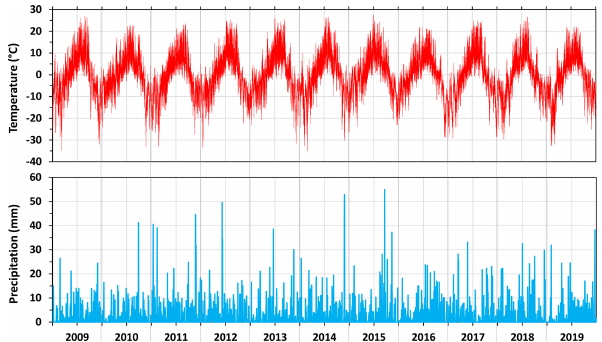
Figure 10. Hourly temperature and daily precipitation recorded at Bow Summit.